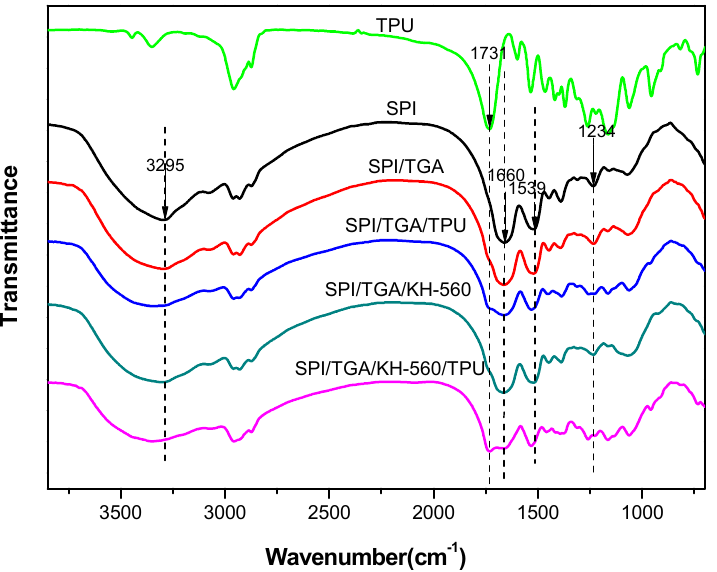
Figure 3. Fourier transform infrared (FTIR) spectra of the thermoplastic polyurethane elastomer (TPU) and different cured adhesives.